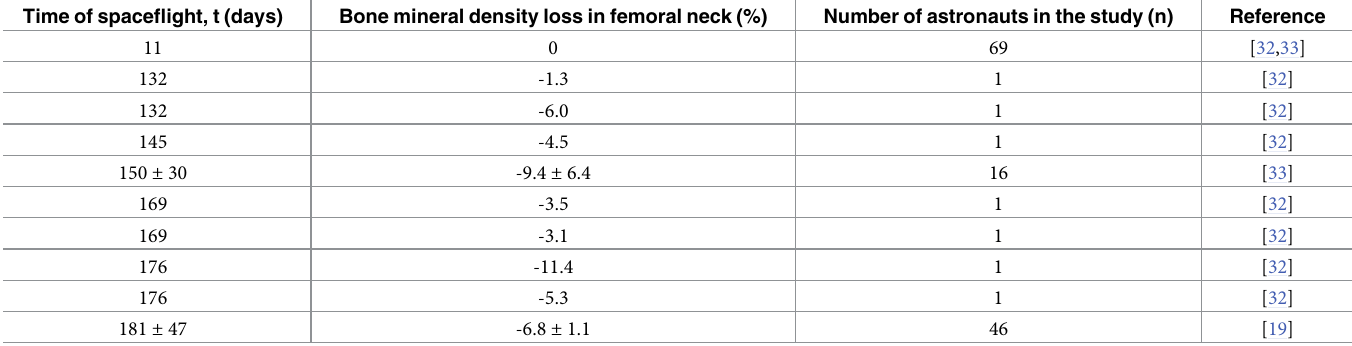
Table 1. Percent loss in bone mineral density at femoral neck in astronauts (N = 69) after 132- to 228-day spaceflights. Time of spaceflight, t (days) Bone mineral density loss in femoral neck